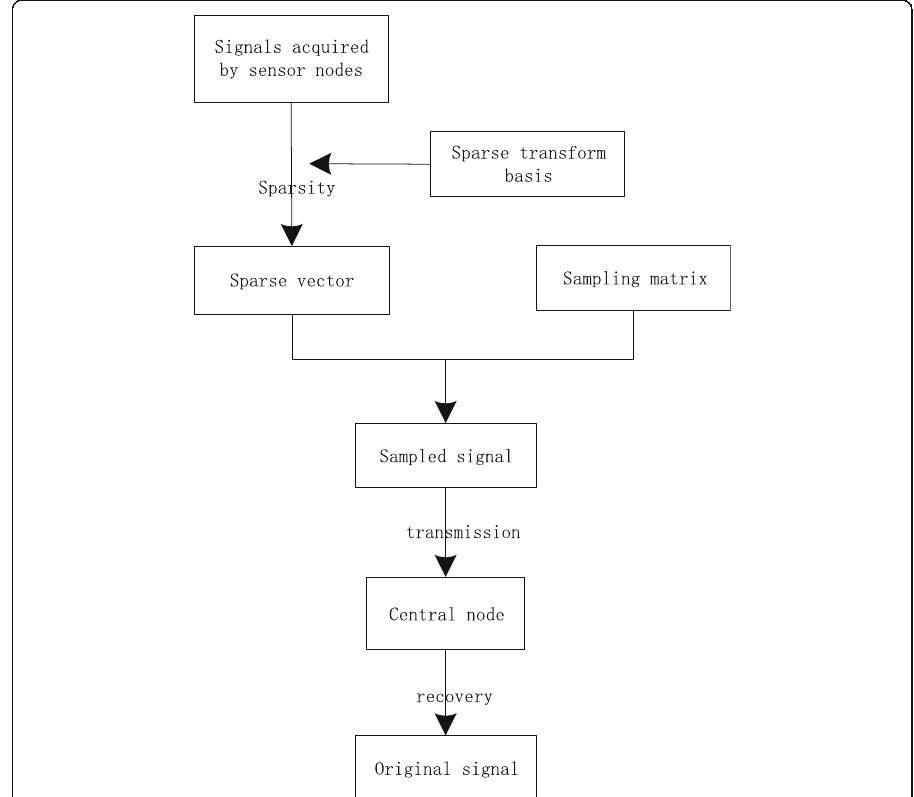
Fig. 2 flow chart of wireless sensor based on compressed sensing. The sensor node obtains the signal, after sparse change, samples sparse signal with the sampling matrix, and then transmits it to the central node for